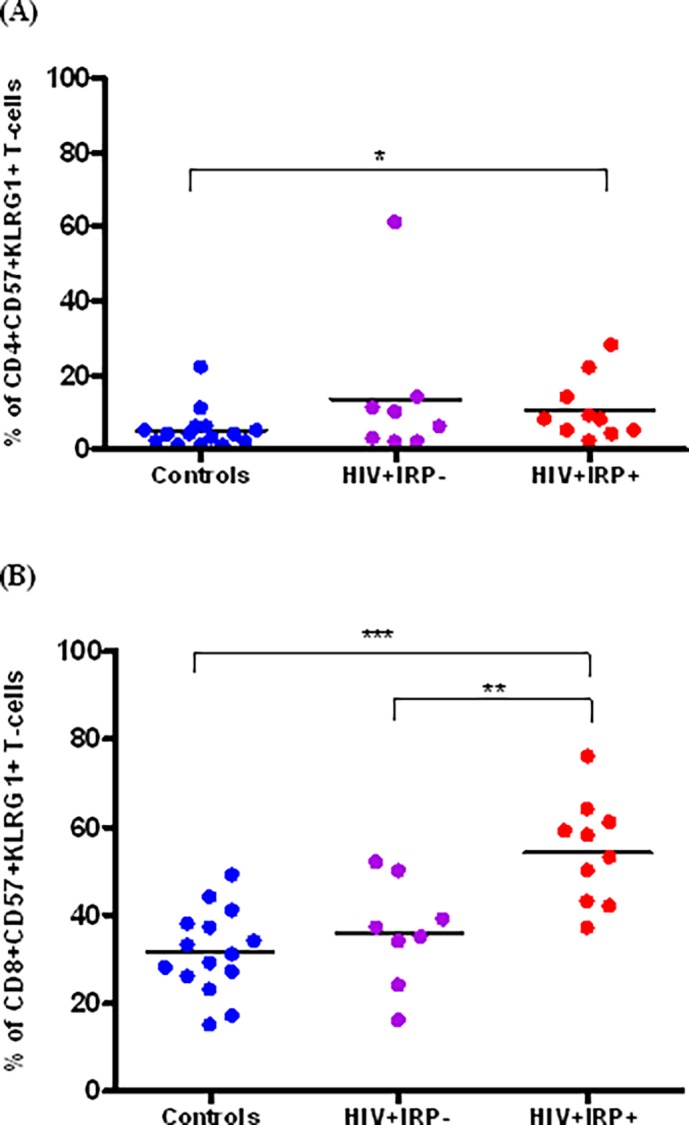
Relationship between the IRP and markers of replicative senescence.The frequency of CD4+ (A) and CD8+ (B) T-cells expressing a both CD57 and KLRG1 was measured and compared in uninfected controls (blue), HIV+IRP- (purple) and HIV+IRP+ (red) sunjects. Statistical significance was determined using the Mann–Whitney U test. *p<0.05, **p<0.01, ***p <0.001.